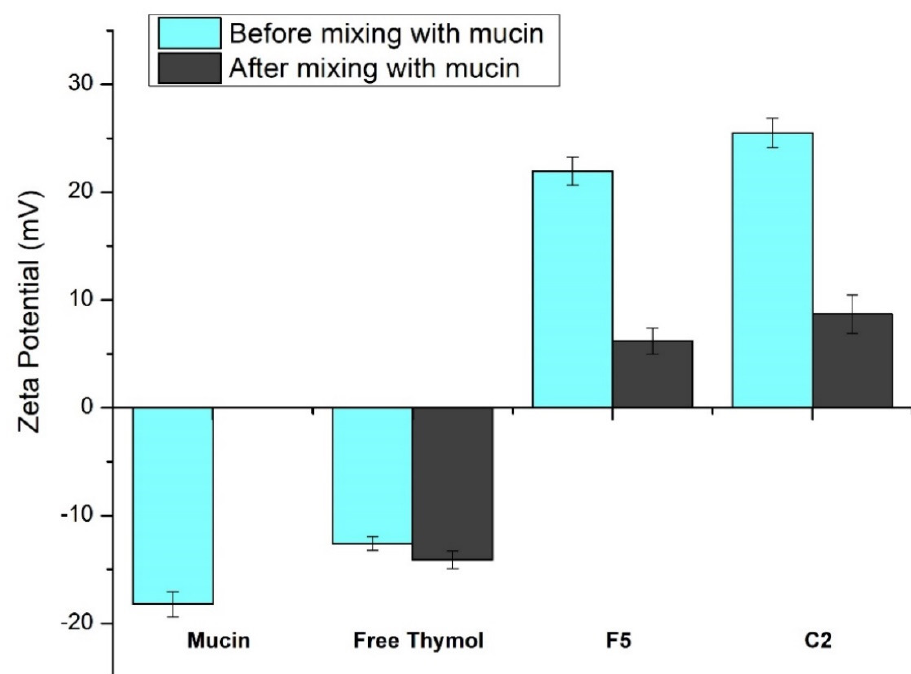
Figure 5. Zeta potential values obtained for mucin and free thymol as well as thymol-loaded CPNPs (F5 and C2) before and after mixing with mucin. Data are displayed as means ± S.D. (n = 3).